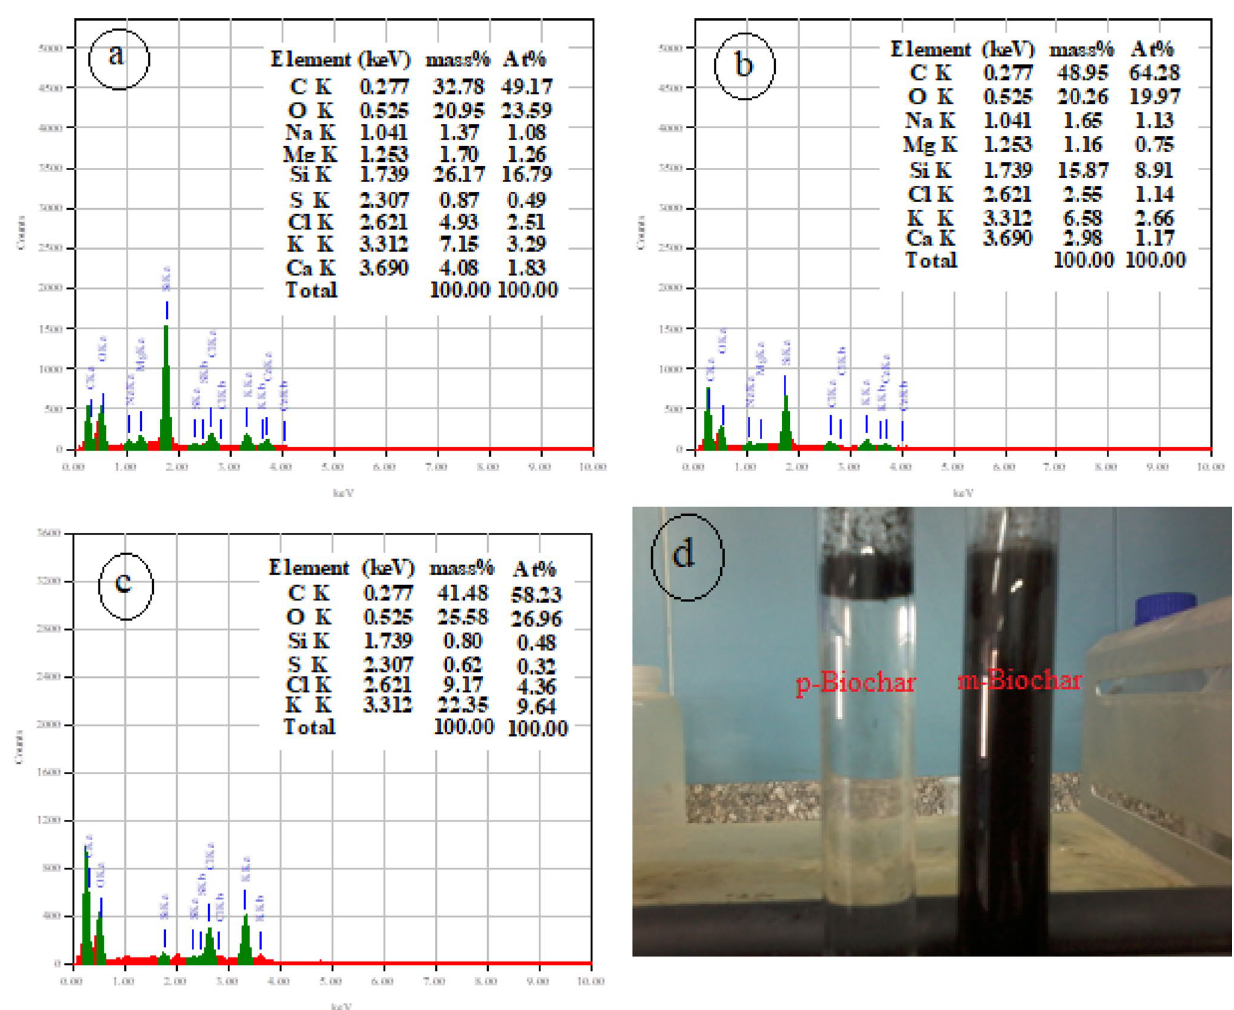
Fig. 2 EDX analysis of a origin ash straw, b p-Biochar, c m-Biochar and d the water dispersibility of p-Biochar and